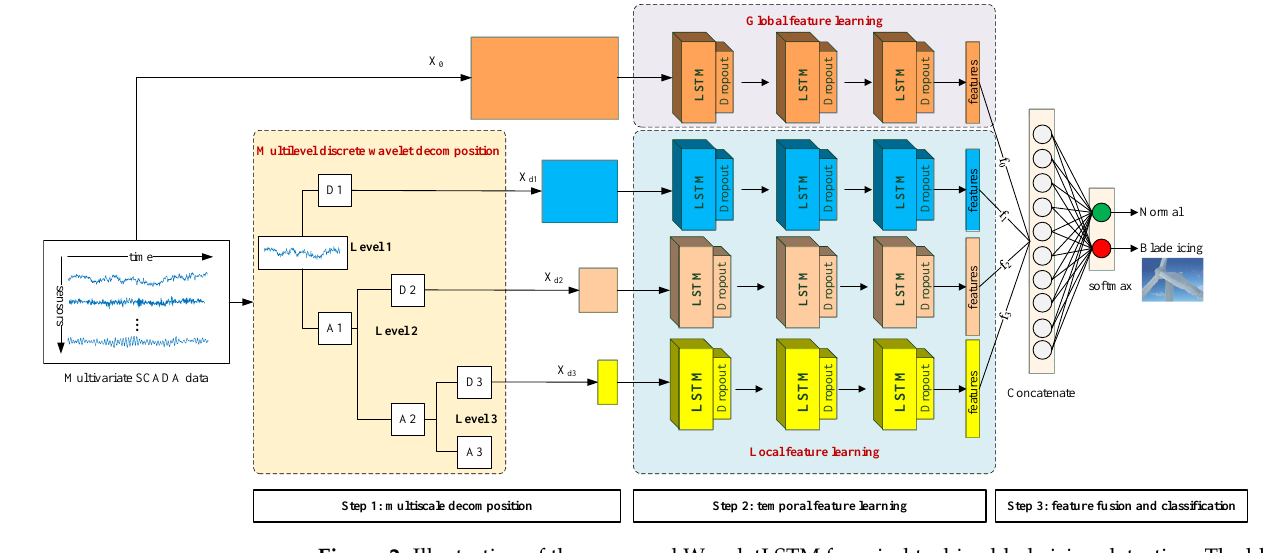
Figure 2. Illustration of the proposed WaveletLSTM for wind turbine blade icing detection. The blade icing picture used in this figure is from